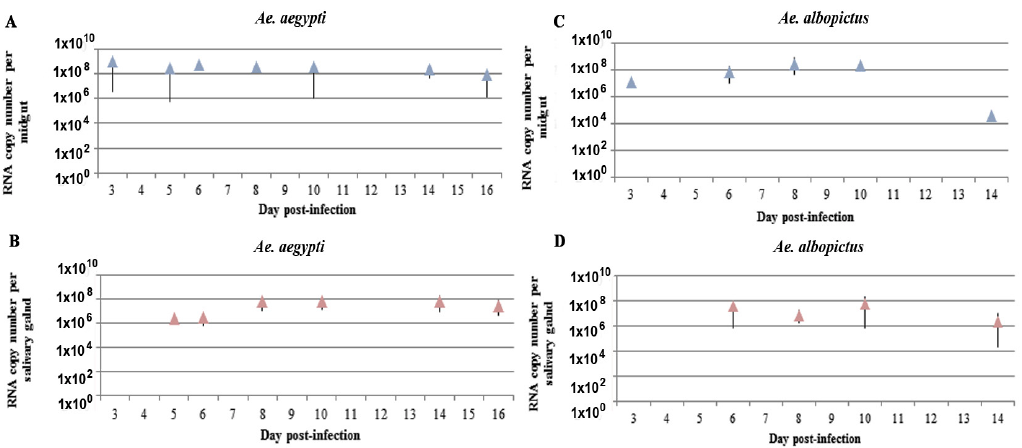
Figure 4. Kinetics of ZIKV infection of MG and SG of Ae. aegypti and Ae. albopictus measured by RT-qPCR. MG ( A , C ) and SG ( B , D ) infected by ZIKV in Ae. aegypti ( A , B ) and Ae. albopictus ( C , D ). Mean (triangles) and standard deviation (vertical bar) are presented for each organ in both species. Five to ten mosquitoes were sampled for each time.